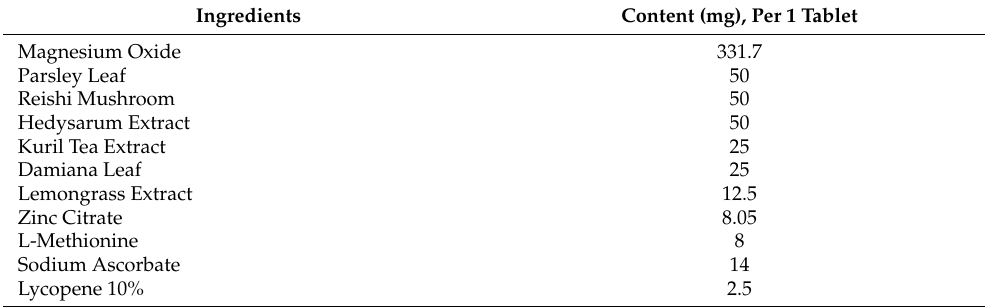
Table 2. Formula 5